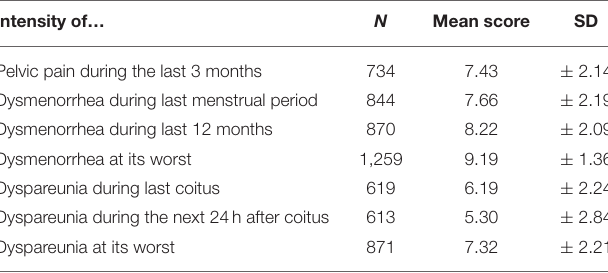
TABLE 4 | Summary of pain intensity measured by